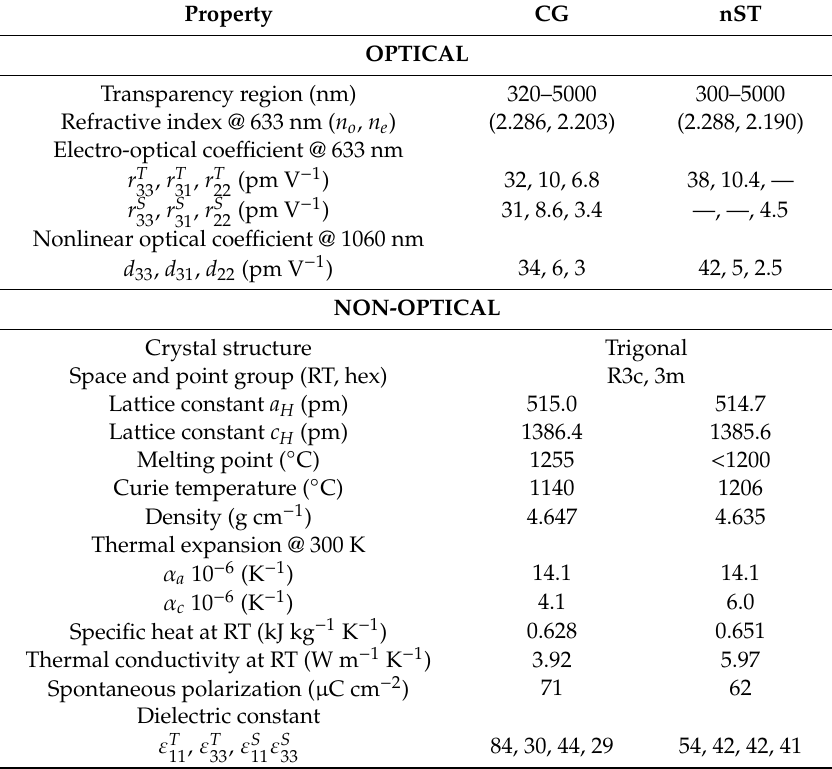
Table 1. Optical and non-optical coe ffi cients for LN single crystals with congruent (CG) and near-stochiometric (nST) compositions—as given by Volk and Wöhlecke in Ref.